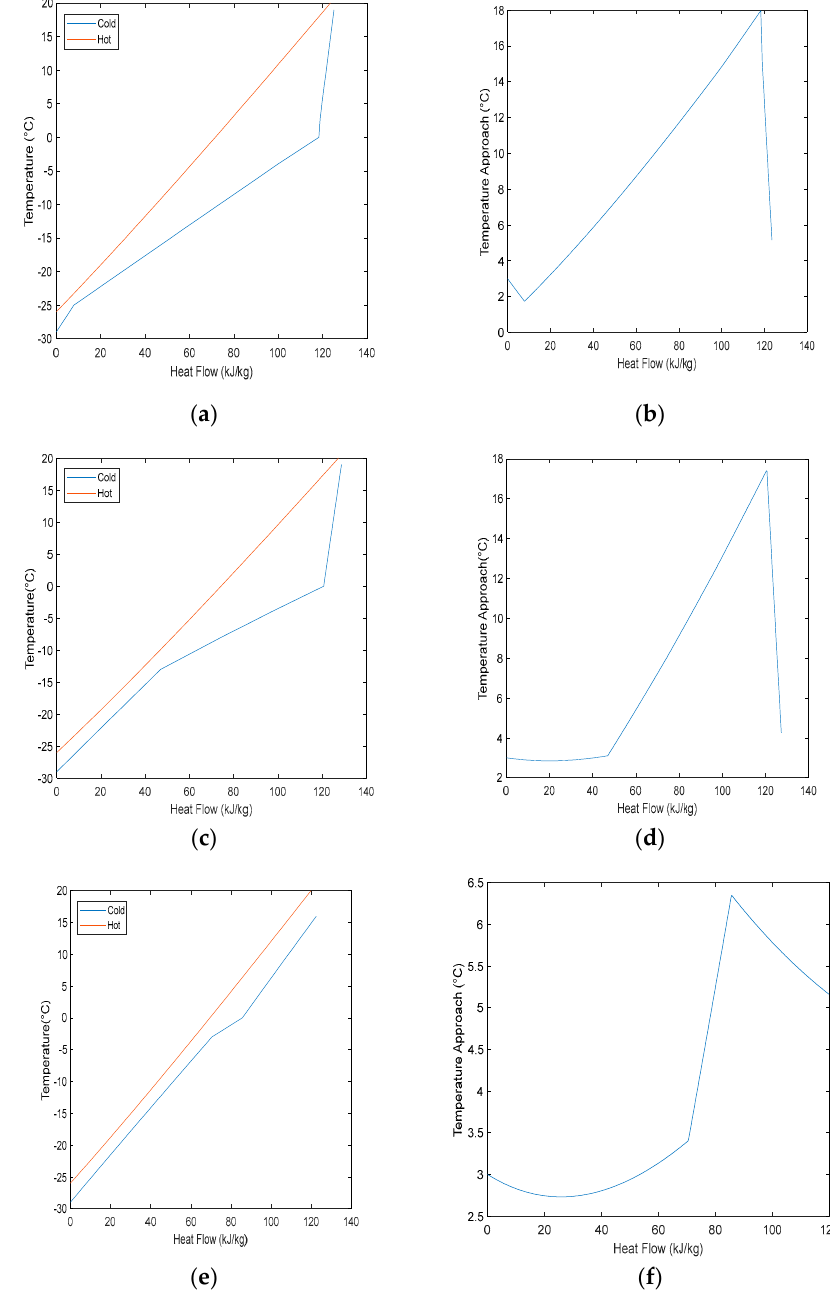
Figure 6. Comparison of NG and MR composite curves. ( a ) NG and MR case study- 1e ; ( b ) Temperature approach of case study- 1e ; ( c ) NG and MR case study- 2e ; ( d ) Temperature approach of case study- 2e ; ( e ) NG and MR case study- 3e ; ( f ) Temperature approach of case study- 3e .